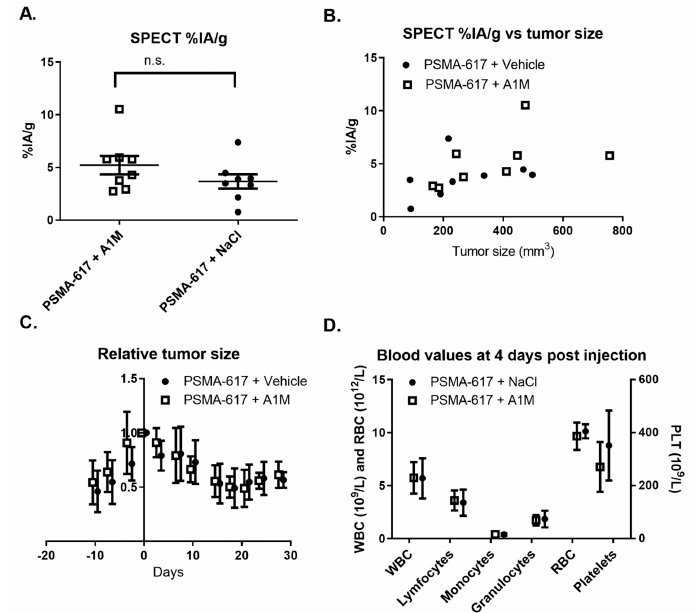
Figure 1. Therapeutic efficacy following administration of 100 MBq of [ 177 Lu]Lu-PSMA-617 with vehicle or with recombi- nant α 1 -microglobulin (rA1M) (5 mg/kg). ( A ) [ 177 Lu]Lu-PSMA-617 tumor uptake 24 h post injection, quantified from single photon emission computed tomography (SPECT) images, in mice given rA1M or vehicle (Data presented as mean ± SEM). The uptake was 5.2 ± 2.3 percent injected activity per gram (% IA/g) (n = 8) for mice treated with [ 177 Lu]Lu-PSMA-617 and rA1M compared to 3.6 ± 1.8% IA/g (n = 8) for mice treated with [ 177 Lu]Lu-PSMA-617 and vehicle, the difference was not significant (n.s.). ( B ) Tumor uptake as a function of tumor size. ( C ) Treatment response of the LNCaP xenografts over time, presented as the relative tumor size compared to tumor volume at start (mean ± SD). ( D ) White blood cells (WBC), red blood cells (RBC) and platelet (PLT) counts for mice treated with [ 177 Lu]Lu-PSMA-617 given rA1M or vehicle (mean ± SD). [ 99m Tc]Tc-MAG3 imaging in mice without tumor was conducted prior to injection (Baseline) and at 3- and 6-months post injection of [ 177 Lu]-PSMA-617, with vehicle or with rA1M (5 mg/kg). The resulting average renograms, or time activity curves (TACs) are pre- sented in Figure 2. The TACs were analyzed with regards to the time to peak, peak value, inclination during the first 5–35 s, slope of initial uptake (SIU) [39], and the 65–125 s incli- nation (excretion), and these values are presented with median and range in Figure 3. At baseline there is little difference between the respective activity groups with overall simi- lar values for all the analyzed parameters, though the mice that received 100 MBq with rA1M have a smaller range (Figure 3A). The two groups of mice given rA1M have a higher SIU median at three months than those not given rA1M and their range display almost no overlap with their six months data (Figure 3A). This in contrast to the groups without